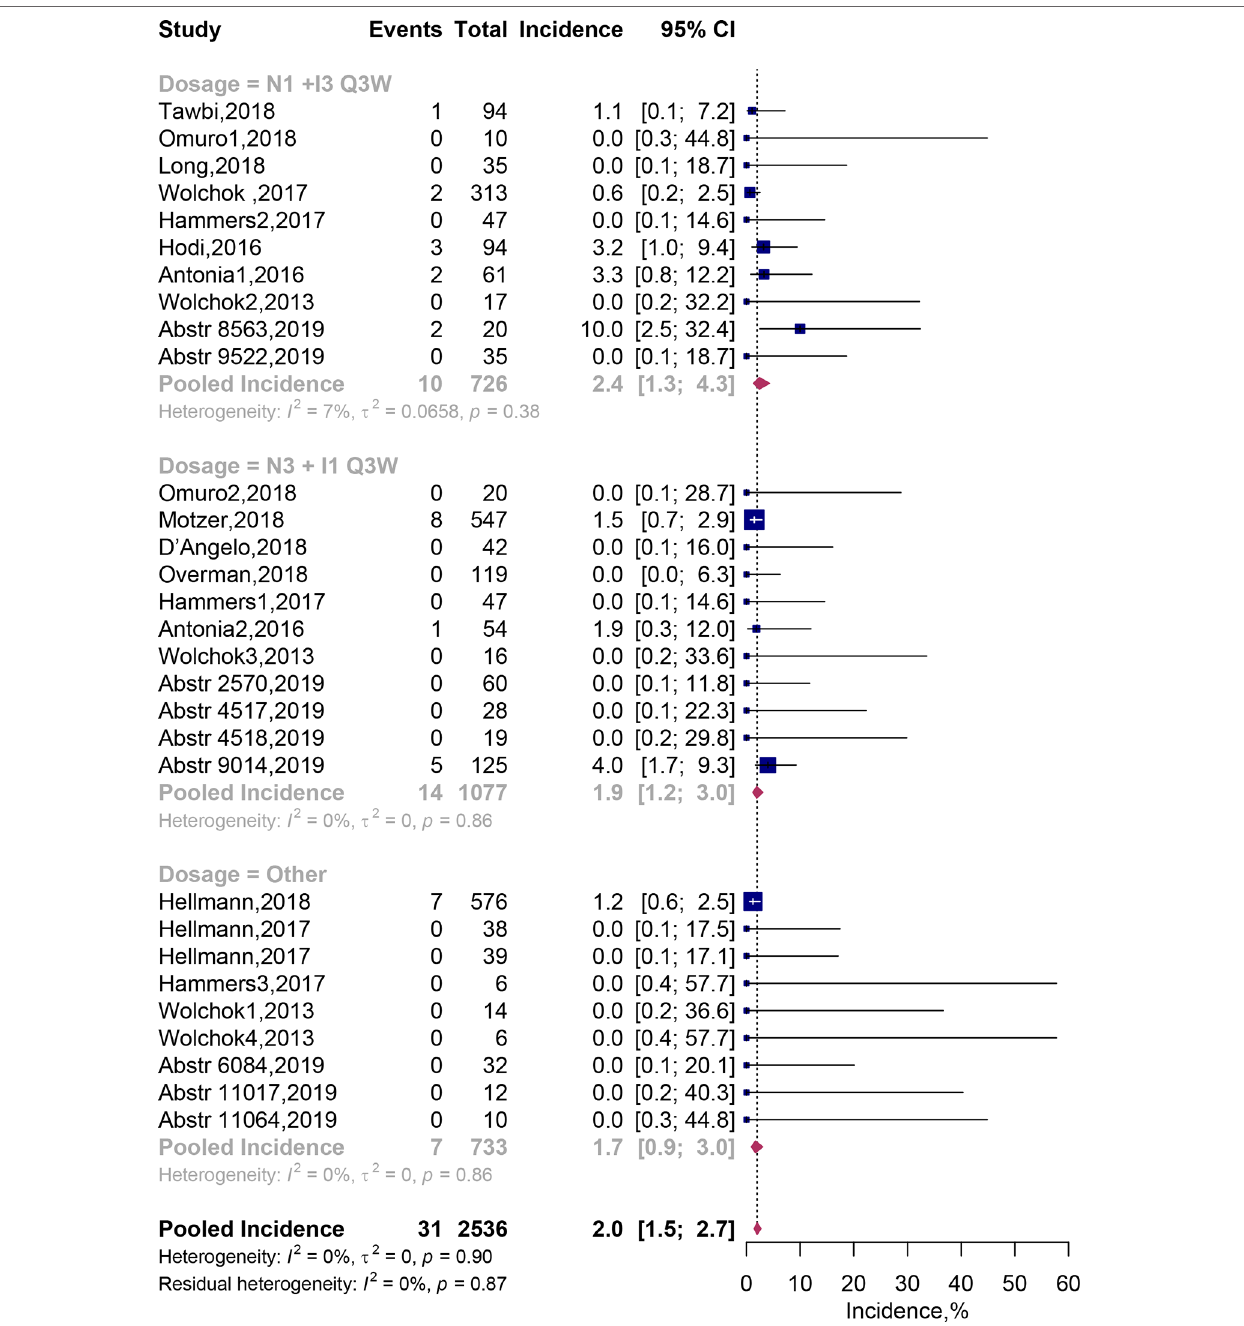
FIGURe 4 | Incidence of fatal adverse events associated with nivolumab and ipilimumab combination treatment. Abstr, Abstract; CI, Confidence interval.